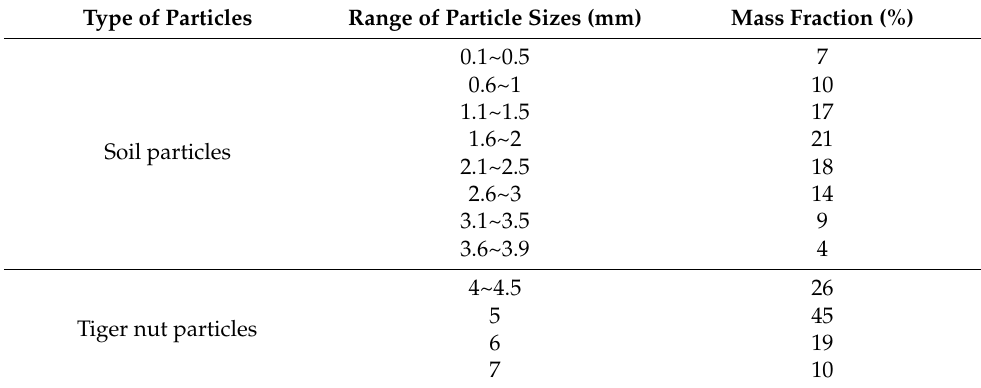
Table 2. Mass fraction of